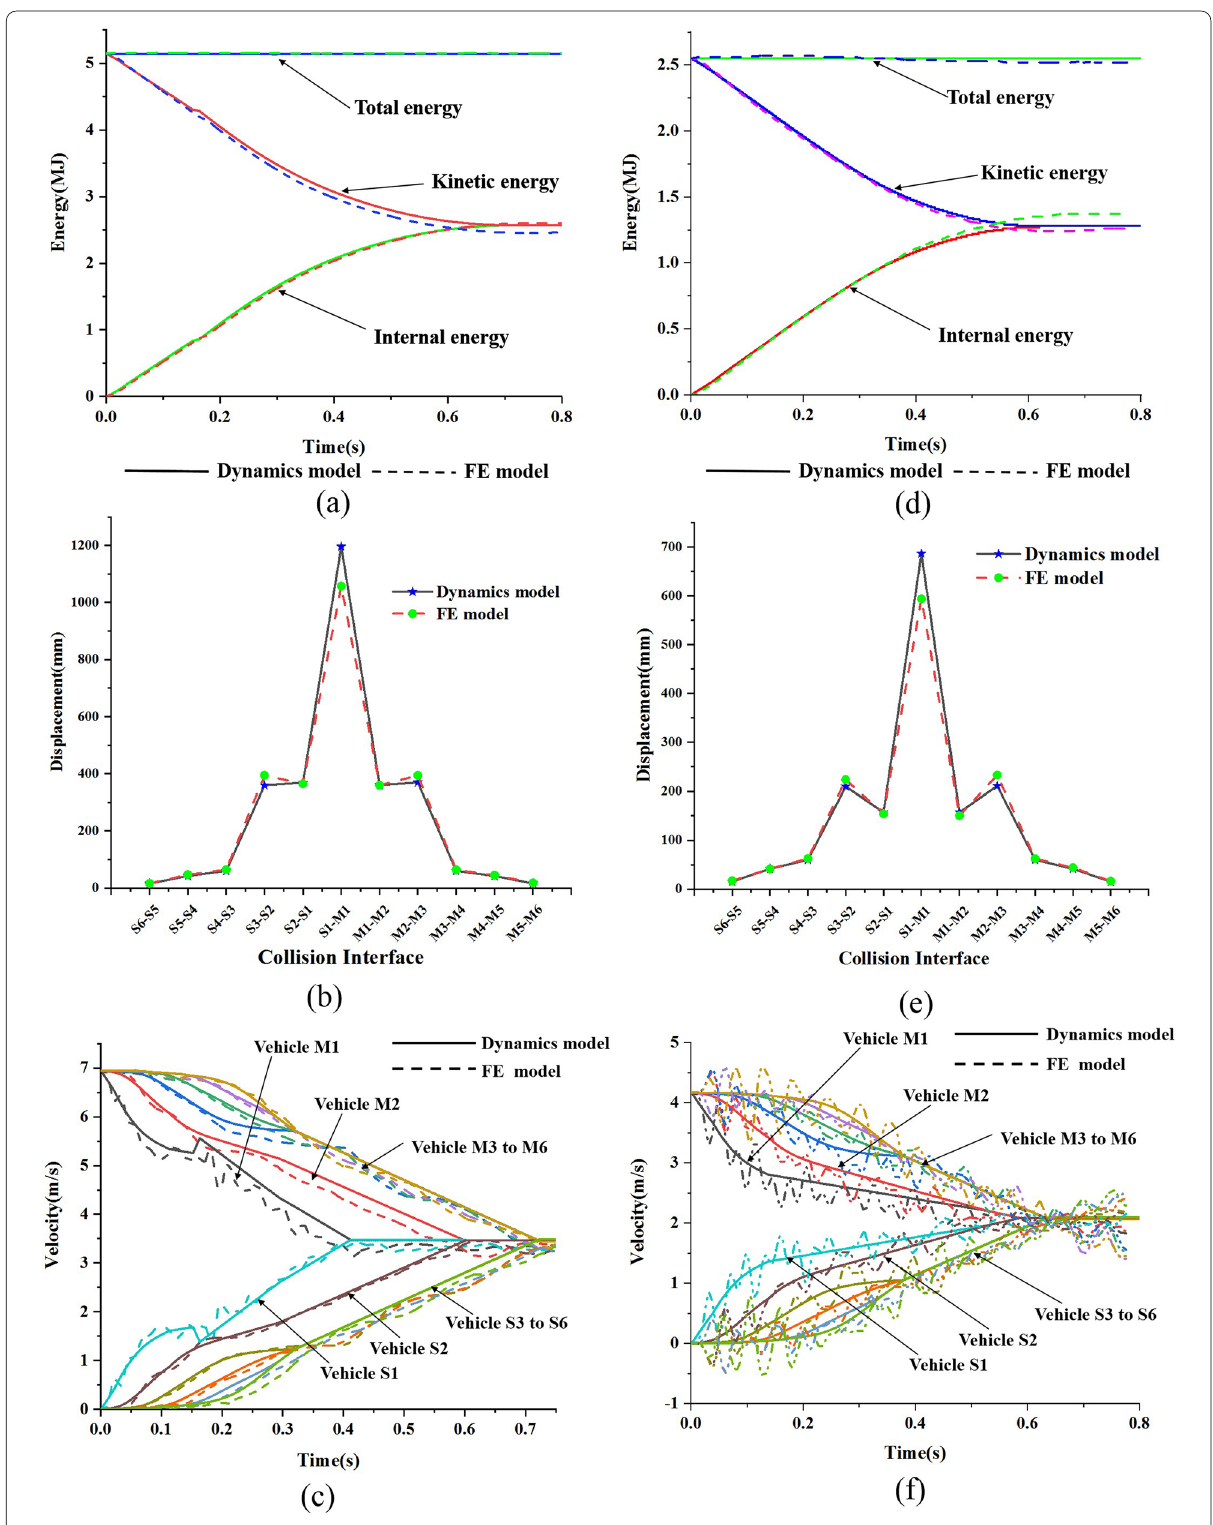
Figure 4 Comparison of the results between the MB and FE models: a Collision energy conversion for scenario 1, b Compression displacement of each collision interface for scenario 1, c Vehicles’ velocity versus time curves for scenario 1, d Collision energy conversion for scenario 2, e Compression displacement of each collision interface for scenario 2, f Vehicles’ velocity versus time curves for scenario